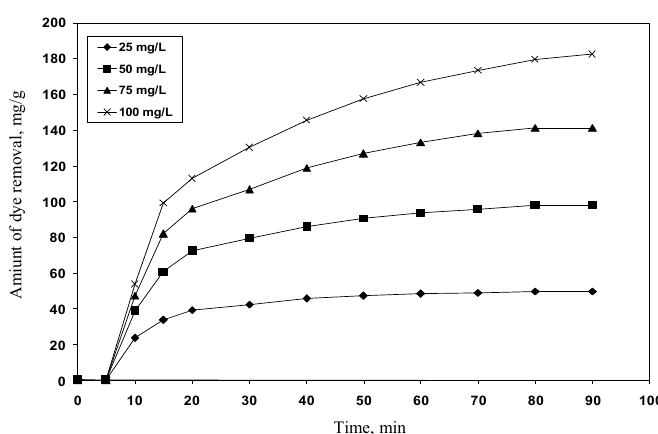
Figure 5. Effect of pH on the adsorption of AG 25 onto ACC.